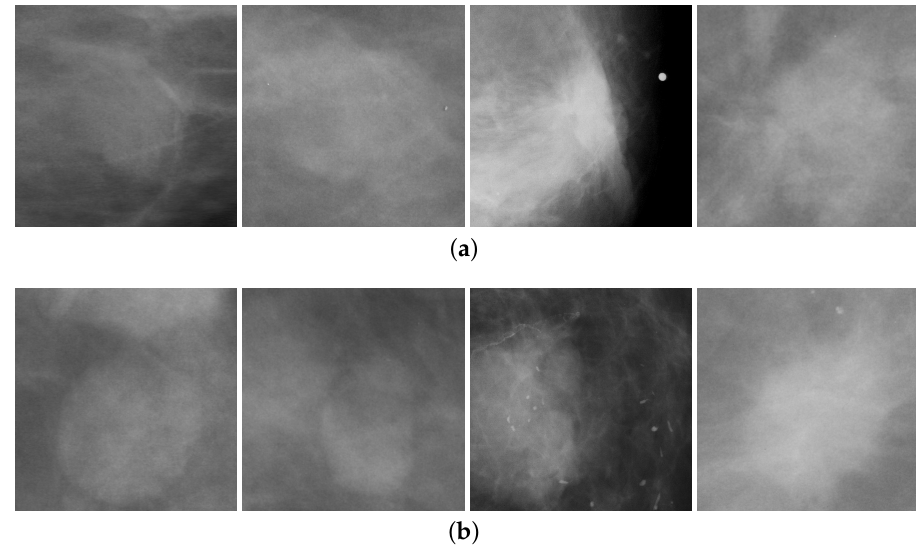
Figure 5. Two benign and two malignant samples from ( a ) the Curated Breast Imaging Subset of DDSM (CBIS-DDSM) and ( b )